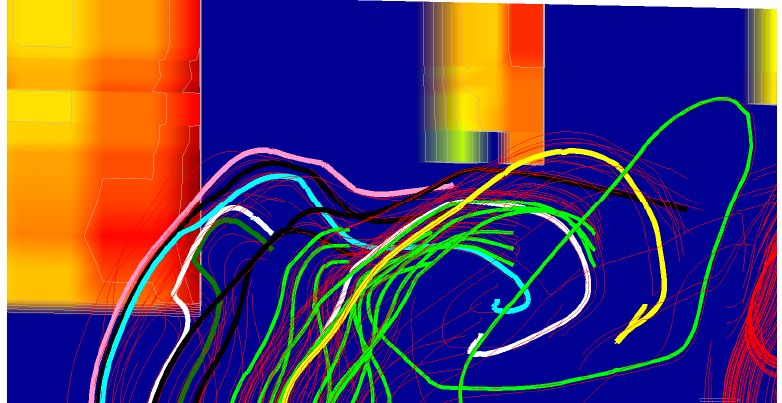
Figure 5. Breakdown of whirl No. 2 with a view of the grooved trough (level 5), Model